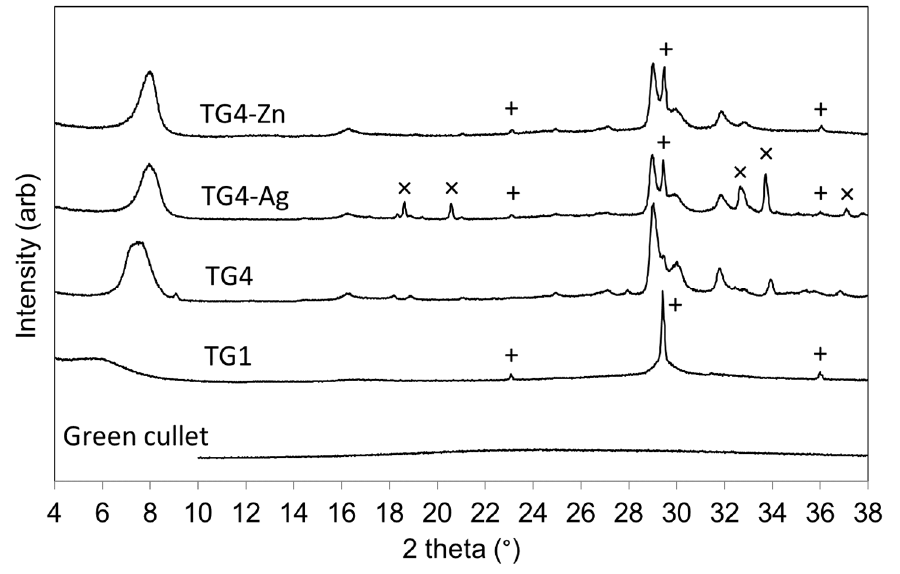
Figure 1. XRD patterns of green cullet and hydrothermal products of green cullet and calcium oxide in 1 M NaOH (aq) (TG1) or 4 M NaOH (aq) (TG4), and Ag + -exchanged TG4 (TG4-Ag) and Zn 2+ -exchanged TG4 (TG4-Zn). Key: + calcite; × silver carbonate; all other reflections arise from tobermorite.